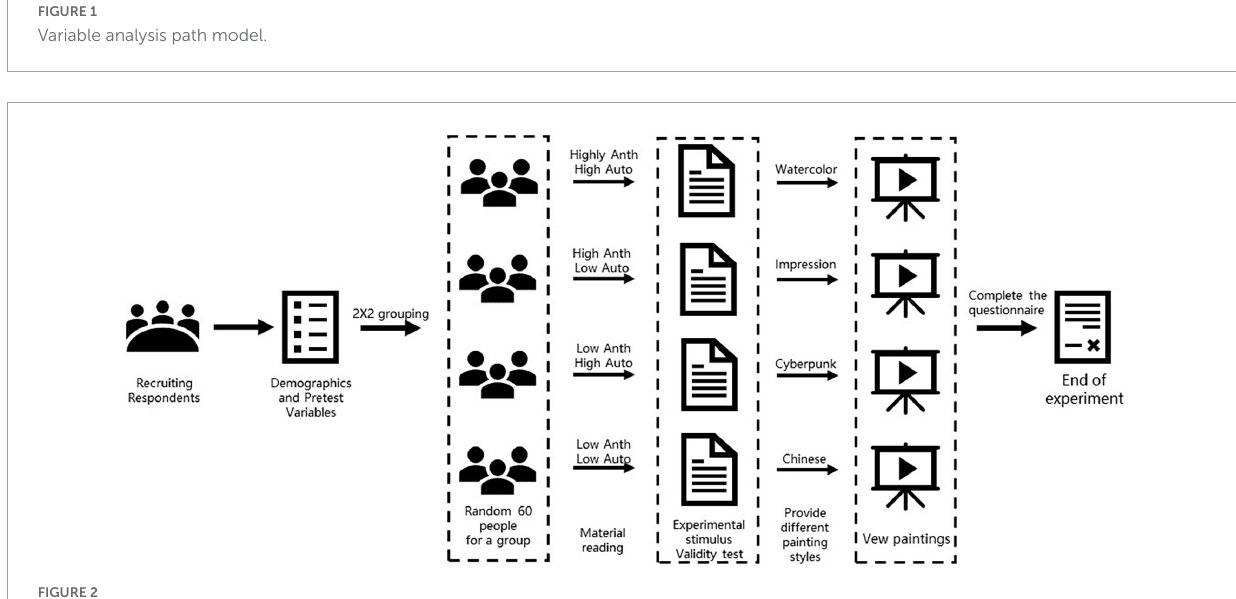
FIGURE2 Experiment